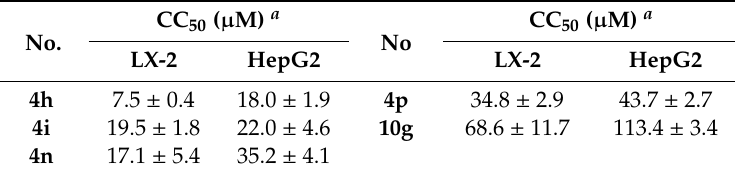
Table 2. The cytotoxicity of representative compounds.